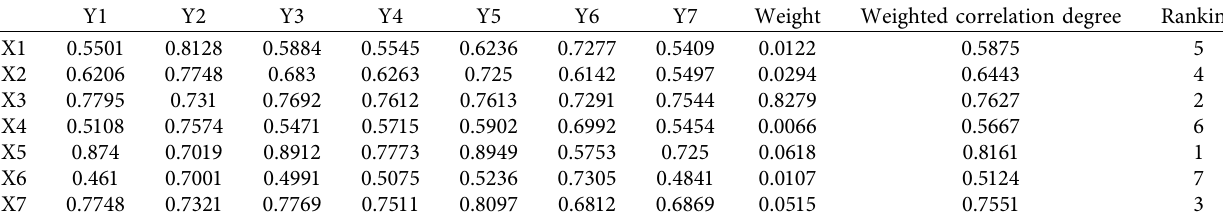
Table 8: Weighted-grey correlation degrees of economic indices to logistics